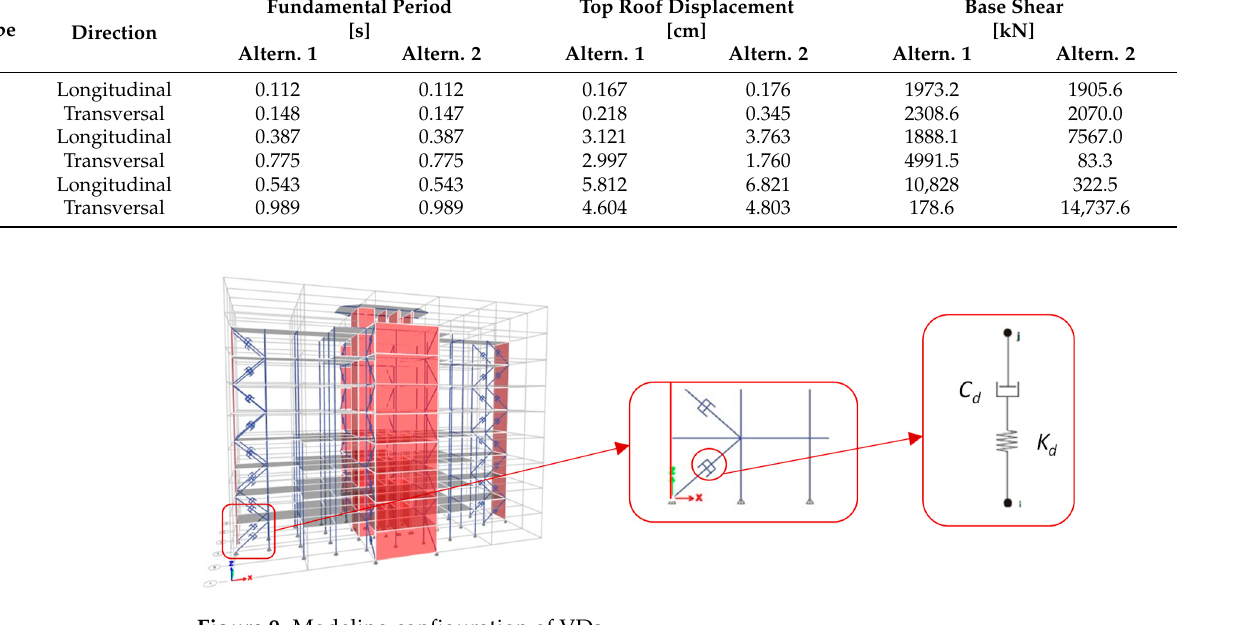
Figure 9. Modeling configuration of VDs.